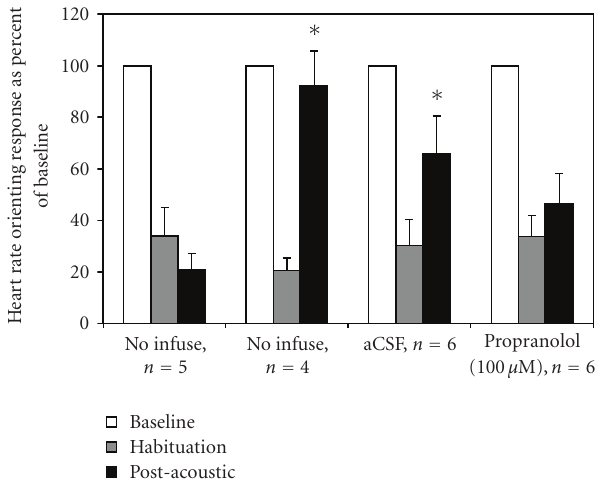
Figure 3: Auditory stimulation induces dishabituation of odor- evoked autonomic reflexes. All groups showed significant habitu- ation of the heart rate orienting reflex (HROR). Initial mean raw response magnitude did not di ff er between groups. Experimental animals were then presented with the siren and odor responses re- tested. Odor-evoked responses in non-infused and aCSF-infused experimental animals showed a significant increase in postacoustic response magnitude compared to habituation levels (asterisk). Con- trol animals, which received no siren stimulus, and propranolol- infused rats that did receive the acoustic stimulus showed no dishabituation. There was no significant change in basal heart rate across time points in any group.